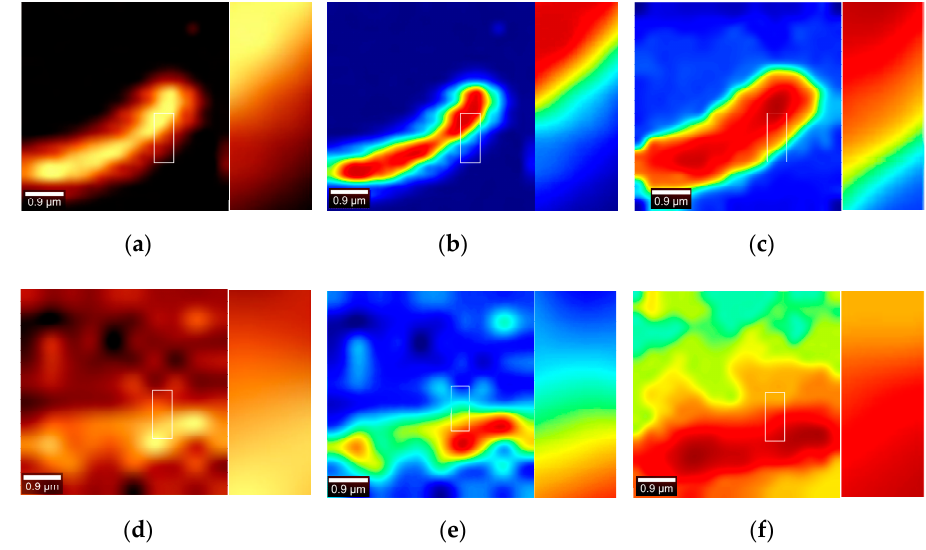
Figure 20. ( a ) Witec pseudo-color imaging in the first set of data in Band 2. ( b ) Witec pseudo-color imaging with the same color bars used in this article. ( c ) Pseudo-color imaging by the method of this paper in the first set of data in Band 2. ( d ) Witec pseudo-color imaging in the second set of data in Band 2. ( e ) Witec pseudo-color imaging with the same color bars used in this article. ( f ) Pseudo-color imaging by the method of this paper in the first set of data in Band 2.